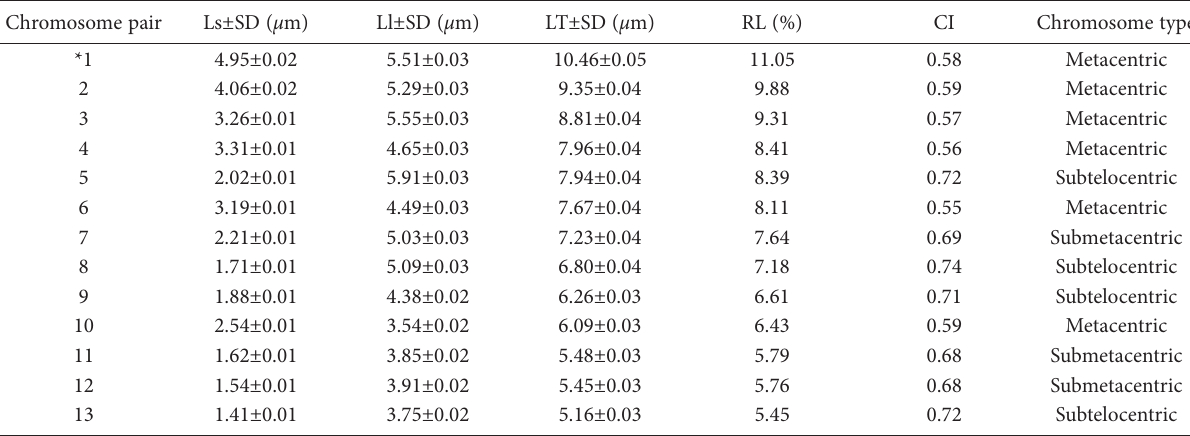
*=satellite chromosome.